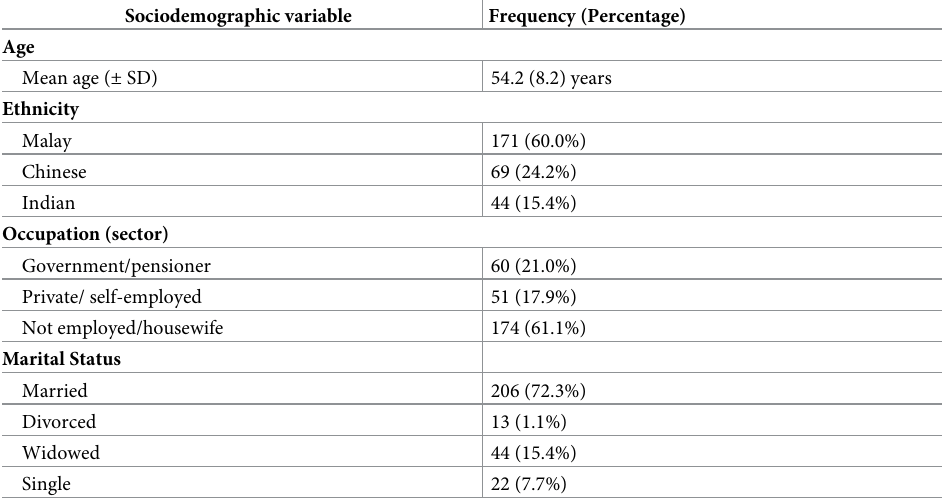
Table 5. Sociodemographic characteristics of respondents who did not undergo mammogram screening (n = 285). Sociodemographic variable Frequency (Percentage)